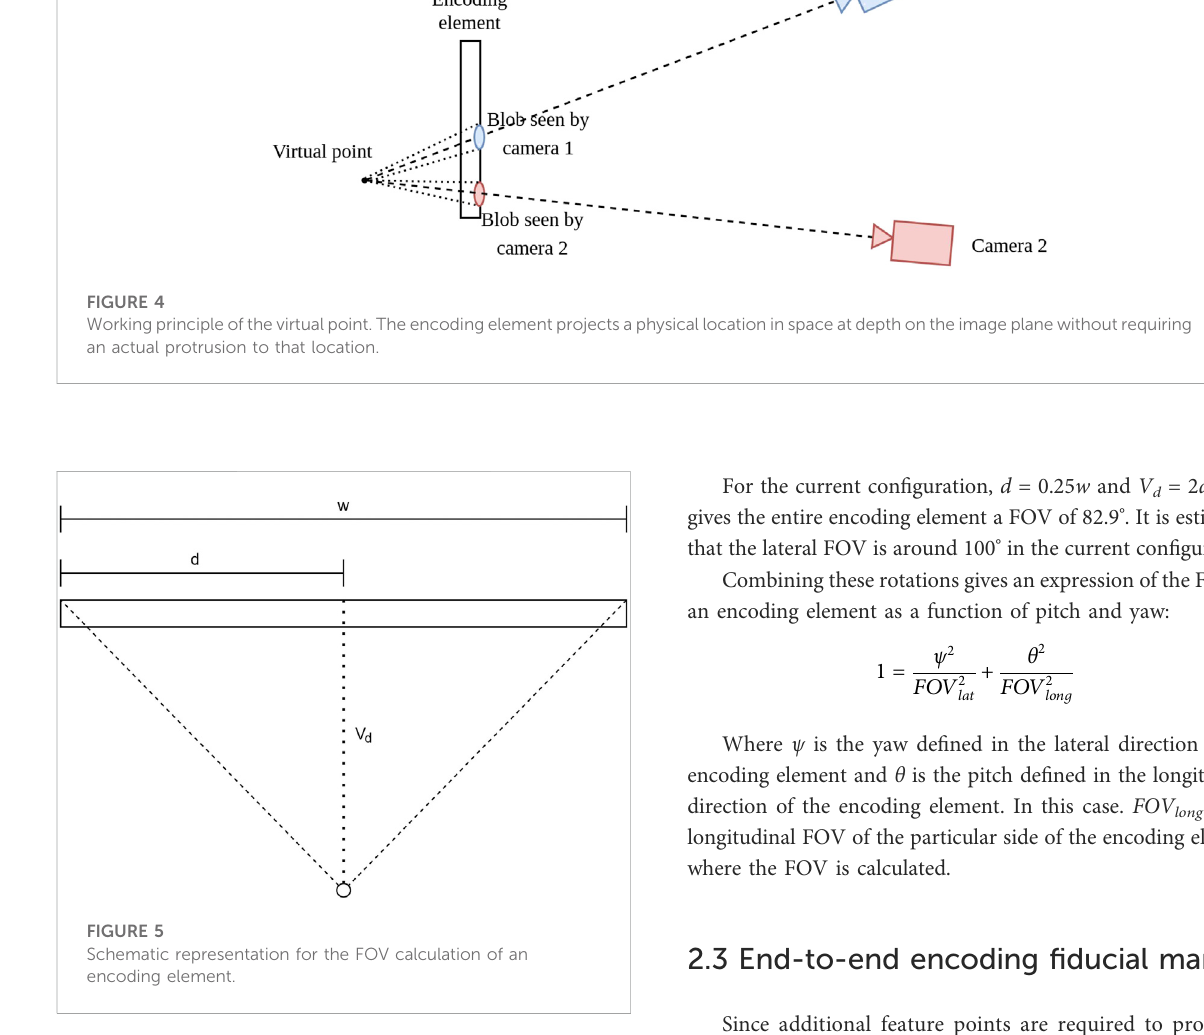
FIGURE 5 Schematic representation for the FOV calculation of an encoding